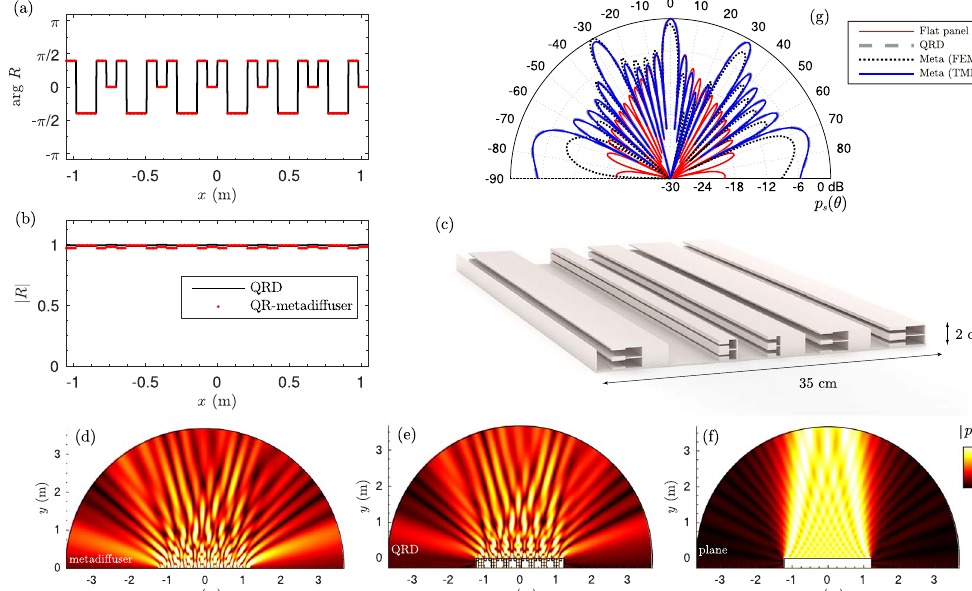
Figure 3. ( a ) Phase and ( b ) magnitude of the spatially-dependent reflection coefficient of a QRD (black line) and the QR-metadiffuser (red doted). ( c ) Scaled scheme of the QR-metadiffuser with N = 5 and M = 2. ( d ) Near field pressure distribution at 2 kHz of QR-metadiffuser with thickness L = 2 cm ( e ) phase grating QRD of thickness L = 27.4 cm and ( f ) flat plane reflector. ( g ) Far-field polar distribution of the QR-metadiffuser obtained by TMM (continuous blue) and FEM (dotted black), the reference QRD (dashed-grey), and a plane reflector with same width of the diffusers (continuous